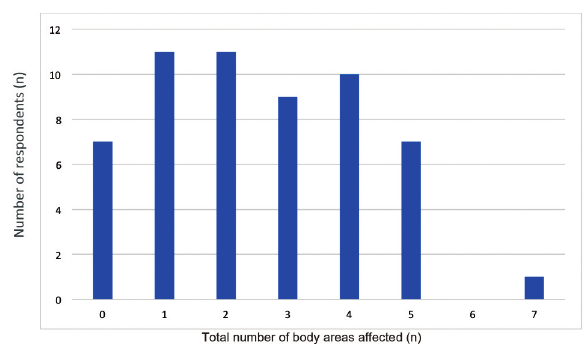
Prevalence of symptoms for each anatomical Fig. 2: